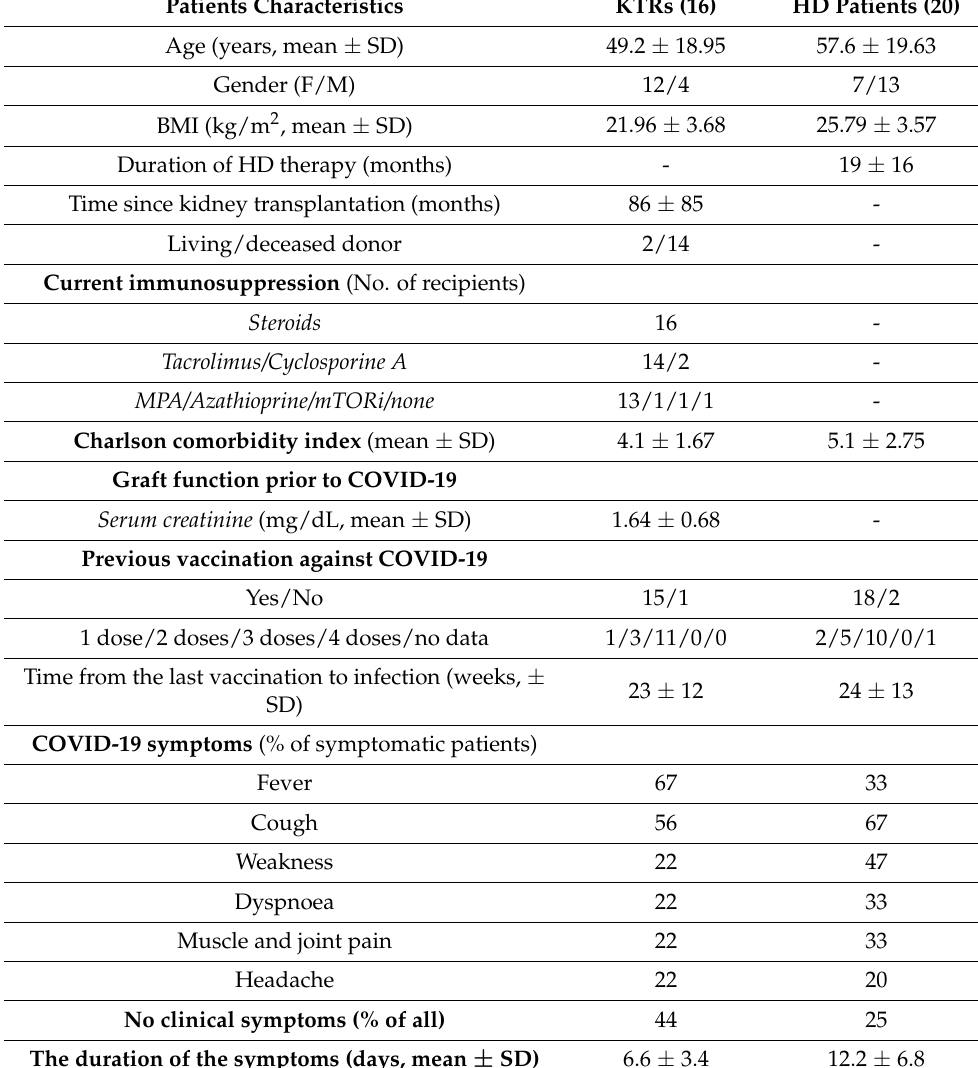
Table 1. Clinical characteristics of sample